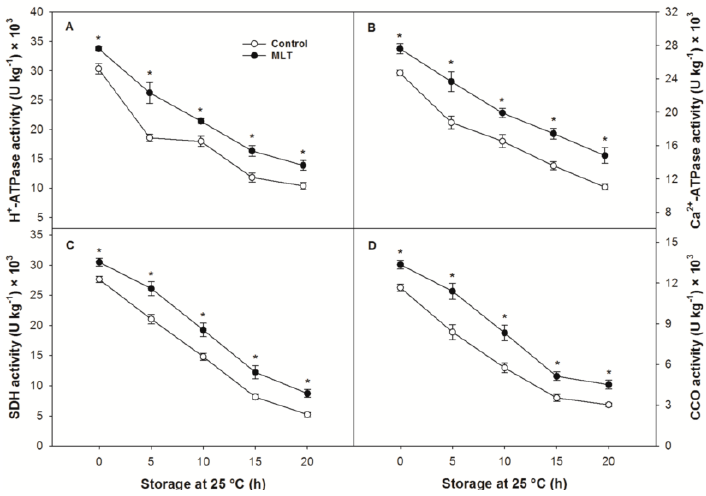
Figure 5. ( A ) H + -ATPase, ( B ) Ca 2+ -ATPase, ( C ) succinate dehydrogenase (SDH), and ( D )